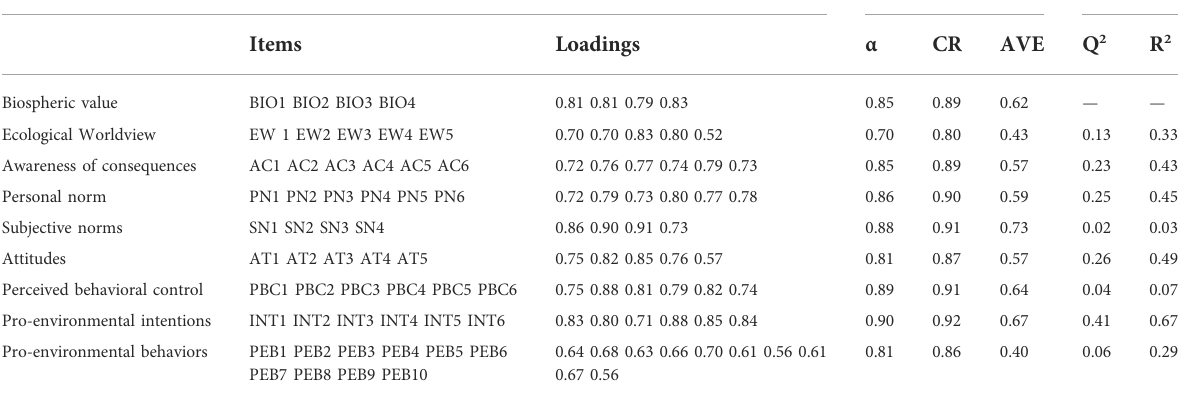
TABLE 2 Assessment results of the measurement and structural models.